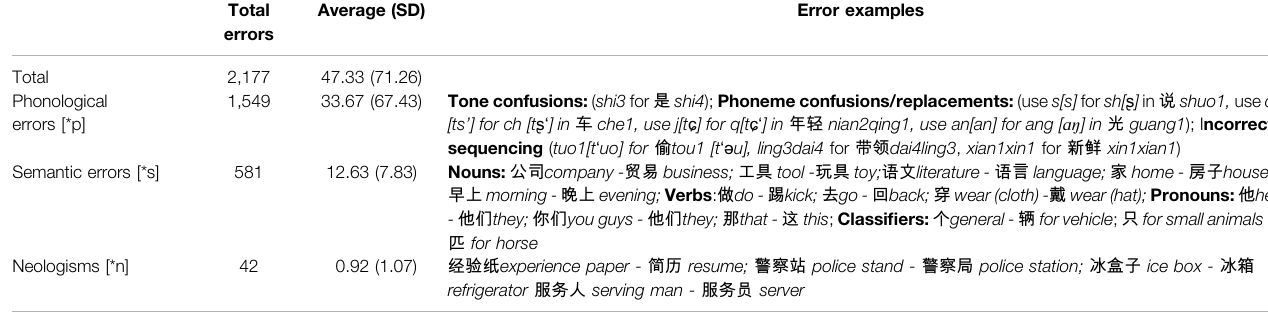
TABLE 4 | Total and average number of production errors shown in second language learners ’ L2 (Chinese). Data is averaged over 46 participants (with English as L1) from the COPA Corpus on TalkBank (Zhang,